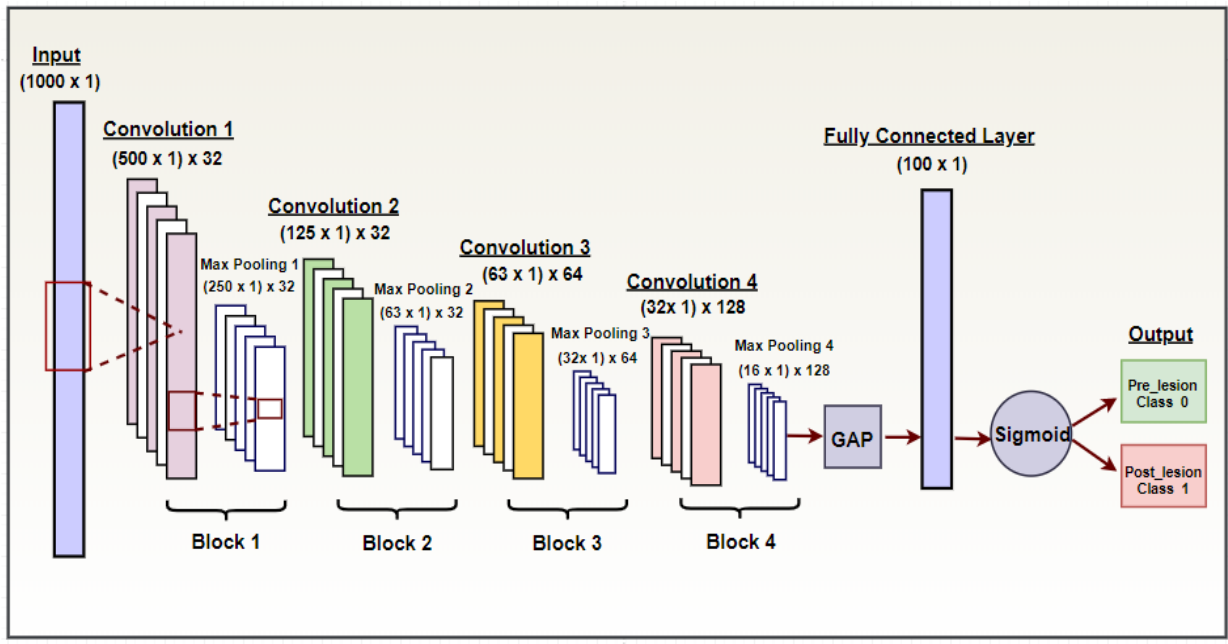
Figure 1. Convolutional neural network structure utilized to build the EMG-based TSCI classification system.